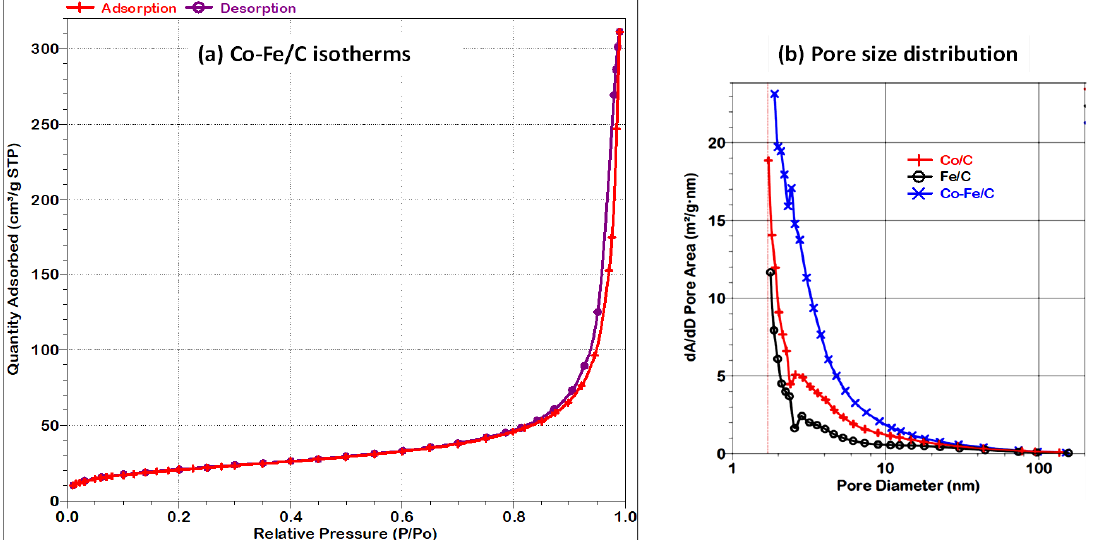
Figure 10. Plots showing ( a ) the adsorption-desorption isotherms of the fresh Co-Fe/C sample, and ( b ) the pore size distribution by the BET surface area